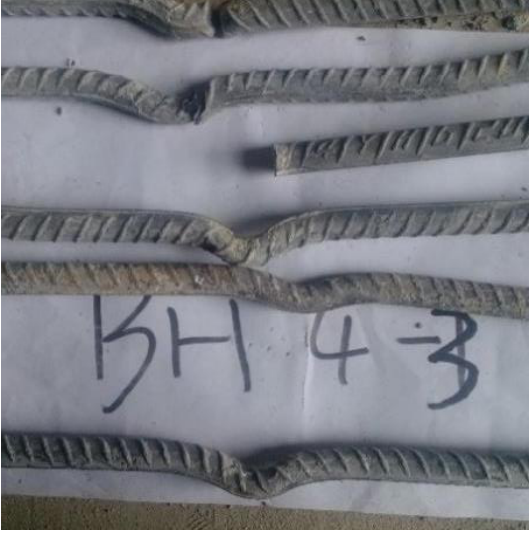
Figure 27. Reinforcement bars failures of the BH4 specimen after the test.